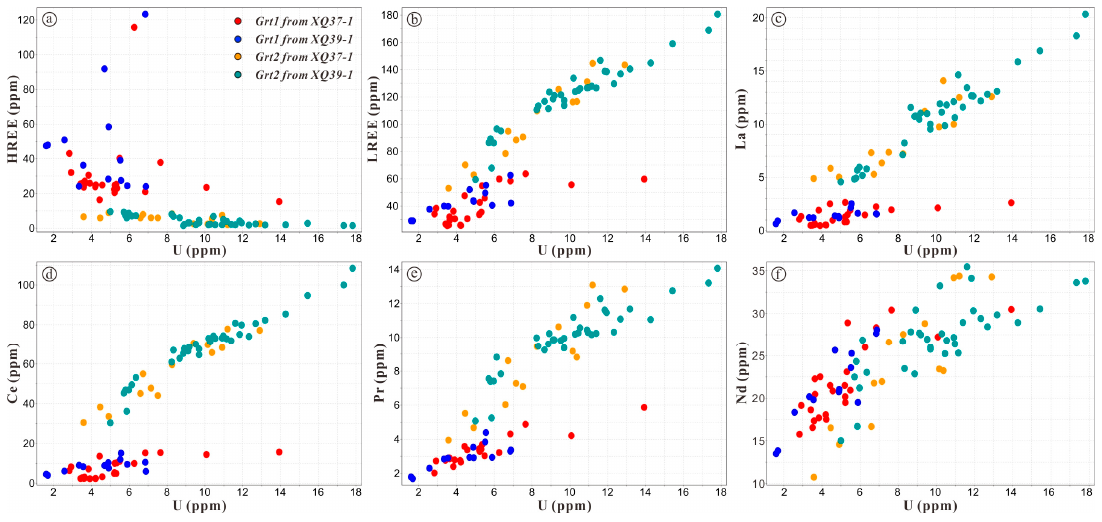
Figure 8. Correlation diagrams between U and ( a ) HREE contents, ( b ) LREE contents, ( c ) La contents, ( d ) Ce contents, ( e ) Pr contents and ( f ) Nd contents.